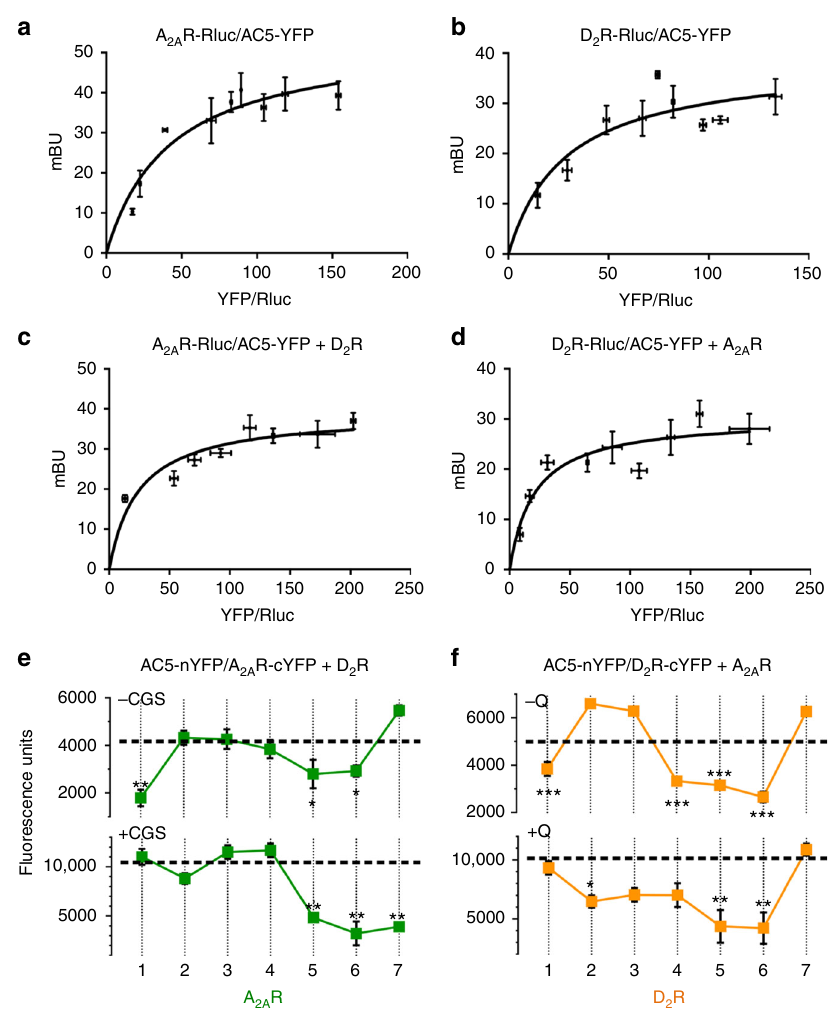
Fig. 3 Involvement of receptor TMs in A 2A R – D 2 R heterotetramer-AC5 oligomerization. a – d BRET saturation experiments in HEK-293T cells transfected with 0.5 μ g of A 2A R-Rluc cDNA and increasing amounts of AC5-YFP cDNA (0.3 – 2.5 μ g) not co-transfected ( a ) or co-transfected ( c ) with D 2 R cDNA (0.5 μ g), or with 0.75 μ g of D – 2.5 μ g) not co-transfected ( b ) or co-transfected ( d ) with A 2 R-Rluc cDNA and increasing amounts of AC5-YFP cDNA (0.3 2A R cDNA (0.4 μ g); the relative amount of BRET is given as a function of 1000× the ratio between the fl uorescence of the acceptor (YFP) and the luciferase activity of the donor (Rluc) and expressed as milli BRET units (mBU) (6 – 8 experiments, with duplicates, grouped as a function of the amount of BRET acceptor). e , f BiFC experiments in HEK-293T cells transfected with AC5-nYFP (0.75 μ g), A 2A R-cYFP (0.5 μ g) and D 2 R (0.75 μ g) cDNA ( e ) or AC5-nYFP (0.75 μ g), D 2 R-cYFP (0.75 μ g) and A 2A R (0.4 μ g) cDNA ( f ); cells were treated for 4 h with medium (dotted lines) or 4 μ M of indicated TM peptides (numbered 1 – 7) of A 2A R ( e ) or D 2 R ( f ) before addition of medium, CGS21680 (CGS; 100 nM; e ) or quinpirole (Q; 1 μ M; f ); fl uorescence was detected at 530 nm and values are expressed as arbitrary fl uorescent units ( n = 8, with triplicates); *, ** and *** represent signi fi cantly lower values as compared to control values ( p < 0.05, p < 0.01 and p < 0.001, respectively; one-way ANOVA followed by Dunnett ’ s multiple comparison tests). Results are